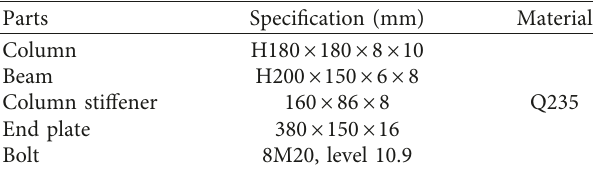
Table 1: Specification and material of the